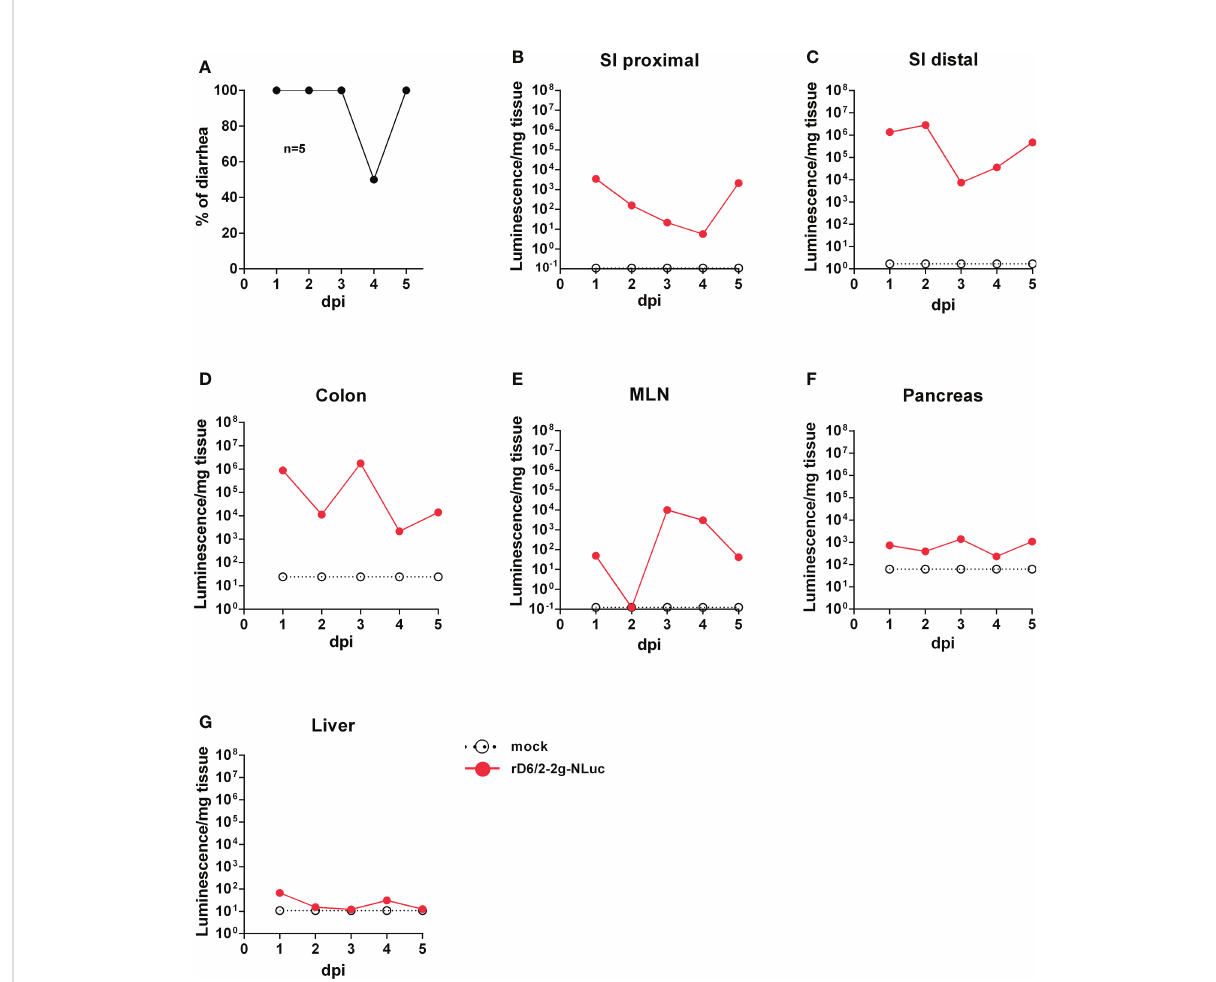
FIGURE 3 Bioluminescence of rD6/2-2g-NLuc in the intestines and the systemic sites in wild-type 129sv mice. (A) Five-day-old wild-type 129sv pups (n=5) were orally infected with 1.3×10 6 FFUs of rD6/2-2g-NLuc and diarrhea was monitored till 5 days post infection. (B – G) Five-day-old wild-type 129sv pups were orally infected with 1.3×10 6 FFUs of rD6/2-2g-NLuc, then euthanized at indicated days post infection. Bioluminescence from indicated tissue homogenates was determined by Nano-Glo ® luciferase assay. Luminescence from NLuc substrate of uninfected mice tissues were plotted as a